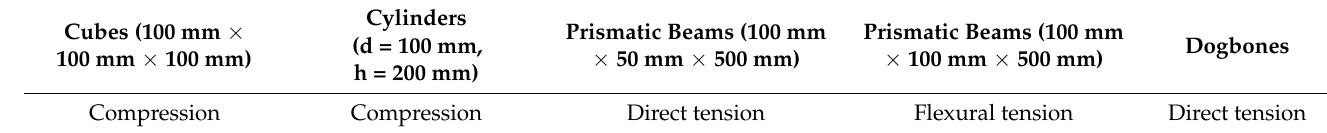
Table 4. Test on each type of specimen.